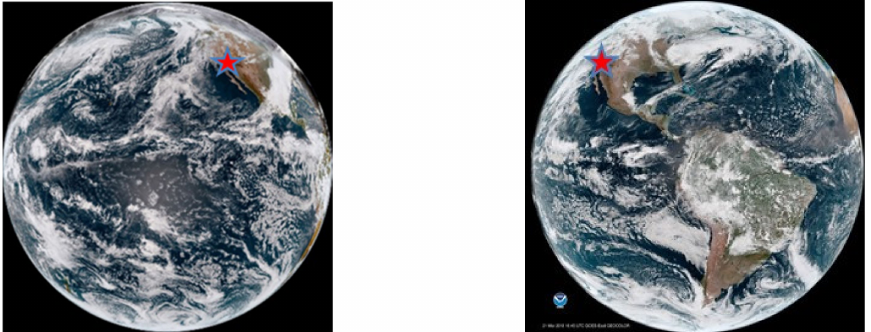
Figure 4. The GOES-West image on the left shows Goes-17 monitoring of the western portion of North America while the image on the right show Goes-16 monitoring the eastern half of North America. The red stars indicate both can monitor the Sonoran Desert PICS.